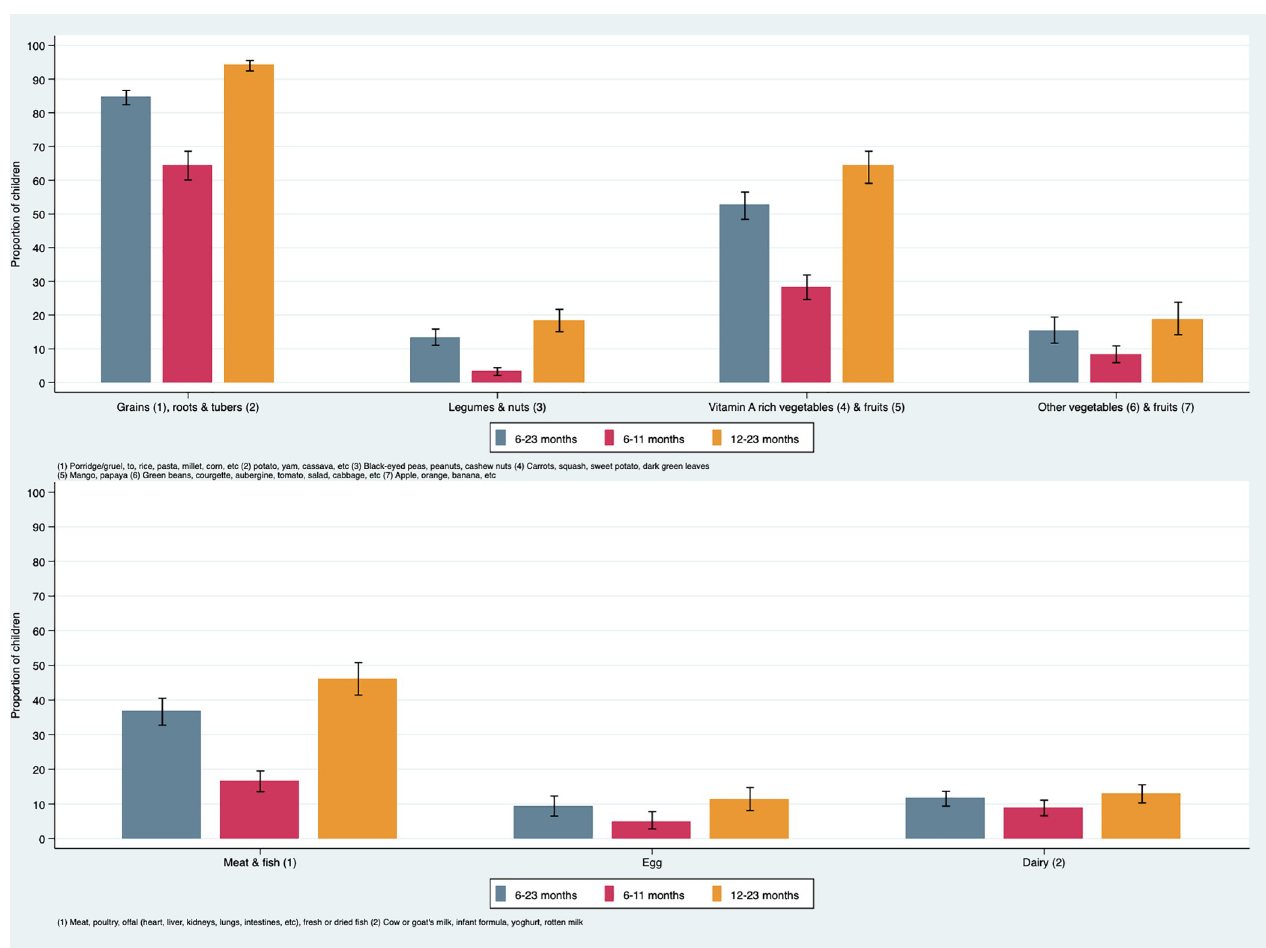
Fig 2. Children dietary diversity and consumption of the seven food groups during the day and night prior to interview (N = 2,229).